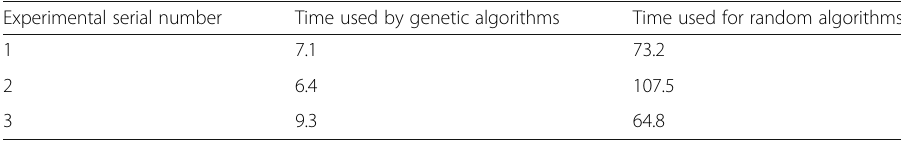
Table 6 Comparison of two kinds of test paper algorithm Experimental serial number